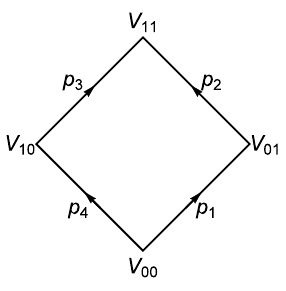
Figure 1 . A single patch of the worldsheet. The four edges are the kink worldlines where the normal vector jumps. In R 2 , 2 these are straight null lines with direction vectors p i